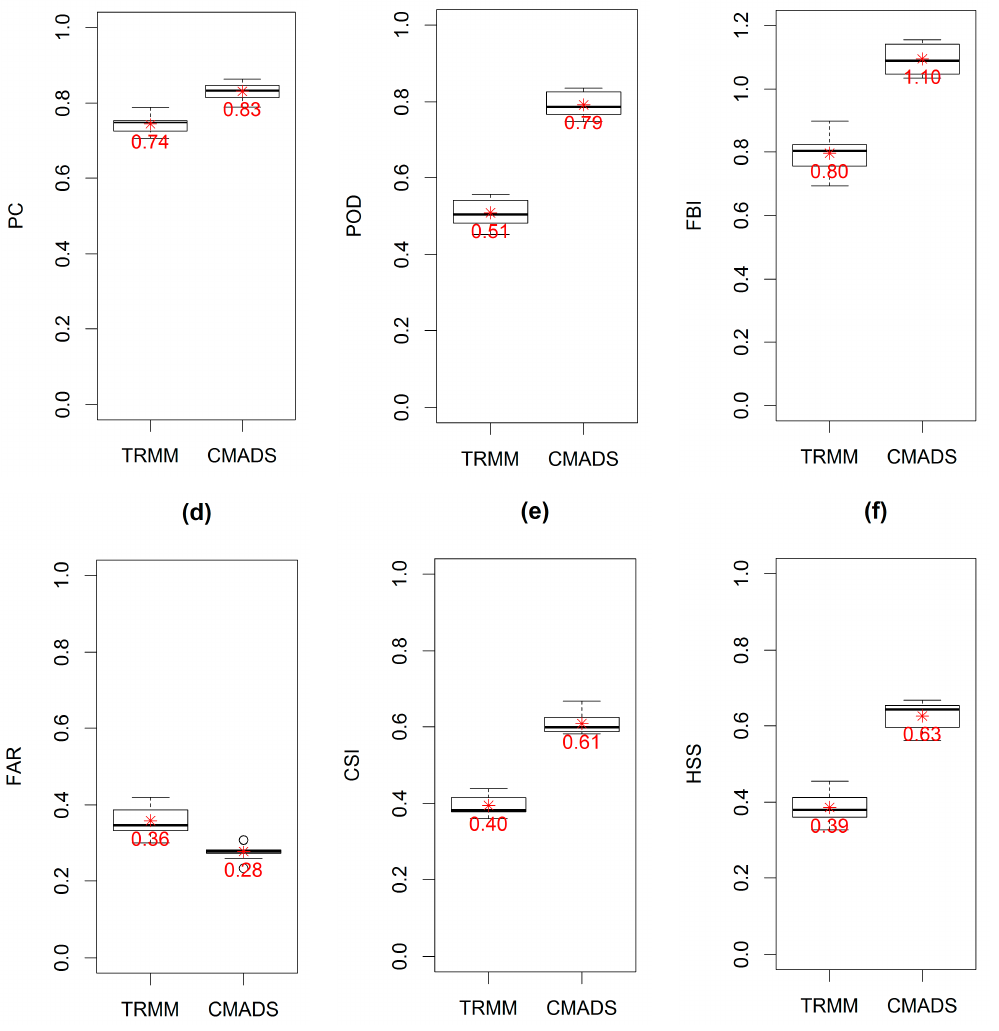
Figure 5. The box plots for the contingency statistics of ( a ) Proportion Correct (PC), ( b ) Probability of Detection (POD), ( c ) Frequency Bias Index (FBI), ( d ) False Alarm Ratio (FAR), ( e ) Critical Success Index (CSI), ( f ) Heidke Skill Score (HSS). The labelled asterisk dot represent the mean value and the middle line in the box represent the median value. Each box ranges from the lower (25th) to upper quartile (75th).